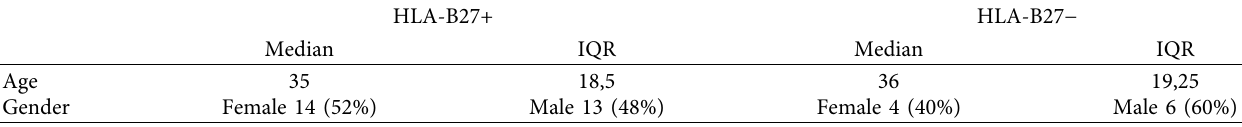
Table 1: The age and gender distribution of the patients.